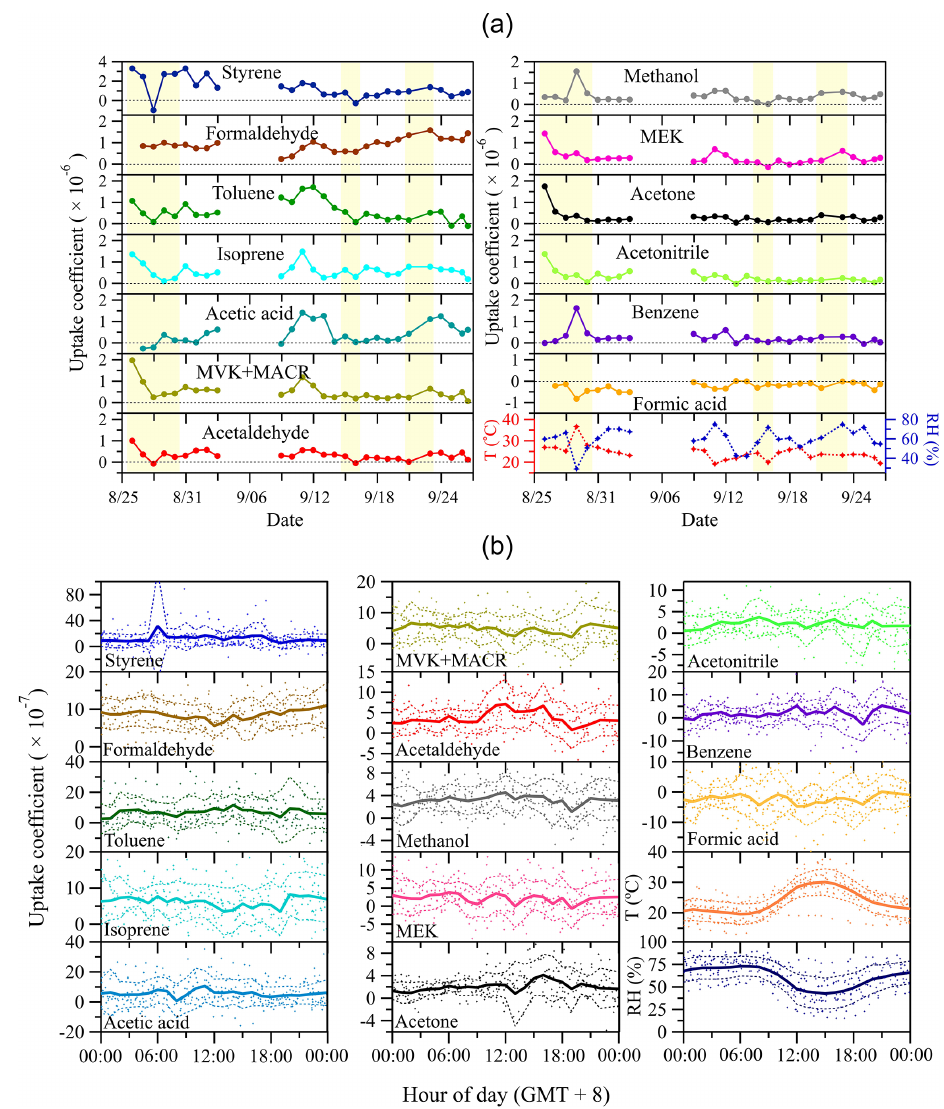
Figure 6. Time series of the uptake coefficients of measured VOC species and air temperature and relative humidity (a) , and respective mean diel courses (b) . In (a) , each symbol represents daily averaged data and the yellow shaded areas indicate the days when measurements were not continuously running all day long. In (b) , symbols denote individual hourly averaged data, and the thick solid lines respective mean diel profiles. Thin dashed lines represent 1 standard deviation ( ± 1SD) from mean